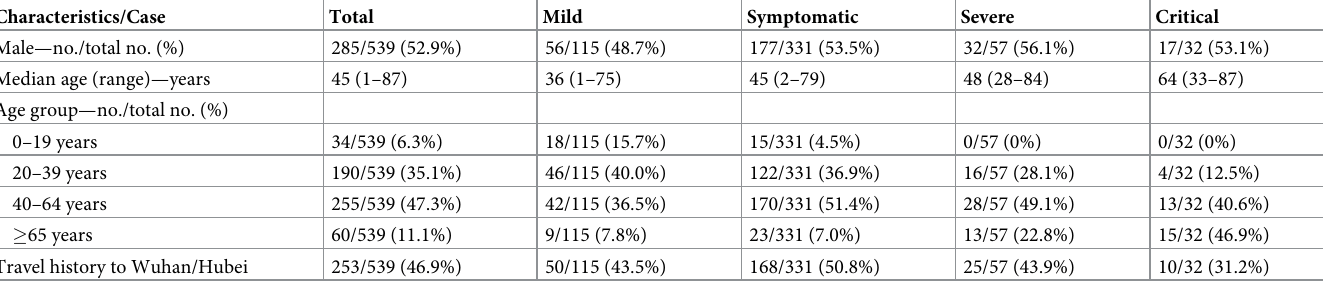
Table 1. Characteristics of laboratory-confirmed COVID-19 cases in Sichuan disaggregated by case severity.